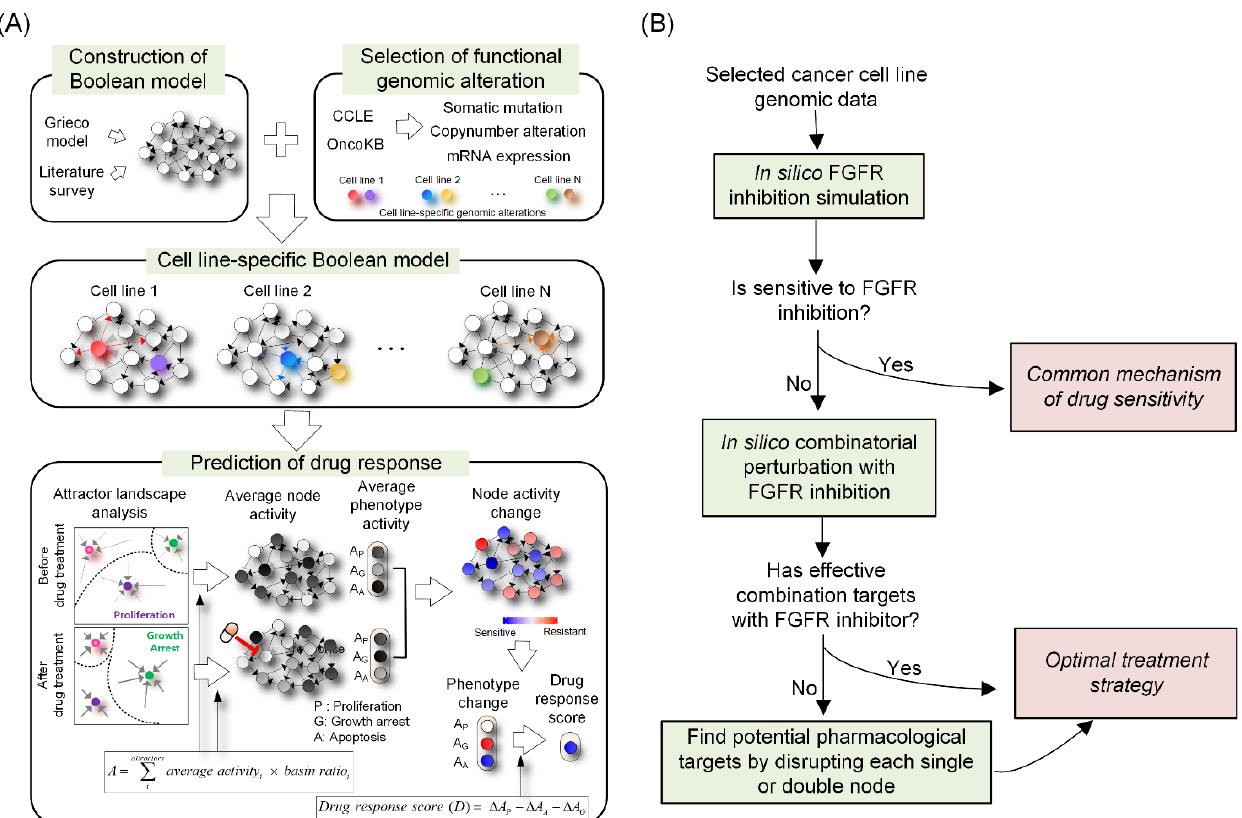
Figure 1. Network dynamics-based cell line-specific drug response prediction model using attractor landscape analysis. ( A ) We gathered data from a Boolean model (Grieco et al., 2013 [24]) and signaling pathways identified from the literature to build a lung cancer-specific Boolean network model. The functional genomic alterations of cancer cells are mapped onto our nominal network model to create differentially wired network models that have distinct network topologies. To predict cell specific drug responses, we conducted systematic perturbation and then analyzed their attractor landscape to calculate average node activity. The final drug response score of each cell line to particular drug is obtained based on the difference between phenotype scores before and after perturbation. ( B ) The procedure of identifying optimal targets from each cell line-specific network model.